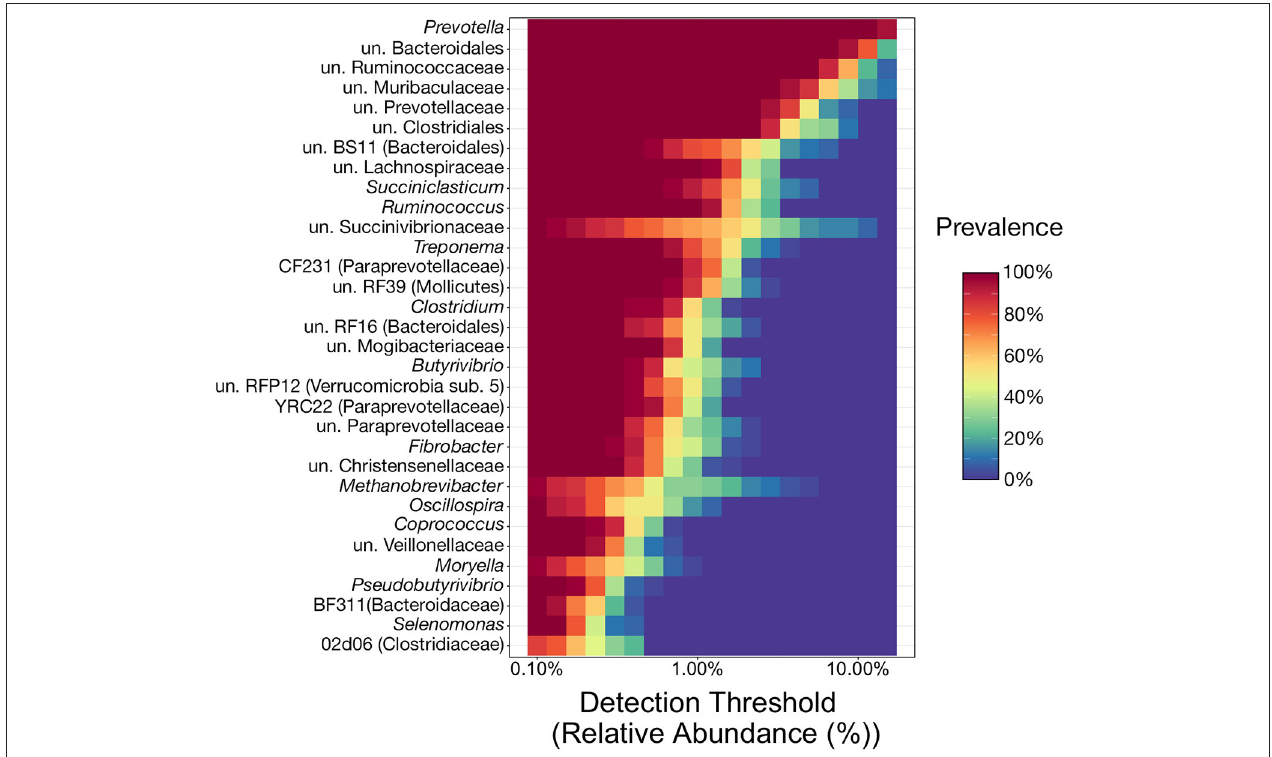
FIGURE 2 | Heatmap illustrating the microbial phylogenetic core of the bovine rumen in feedlot cattle at the taxonomic rank of genus. To be considered core taxa, genera needed to comprise more than 0.1% of the overall microbial community and be present in at least 80% of all samples ( n = 36). With the relative abundance values on the x-axis, the heatmap demonstrates the prevalence of the 32 genera considered core taxa at differing relative abundance levels (from the 0.1% minimum cutoff to the maximum observed value of 30.6%). This results in genera with high prevalence values at high relative abundances near the top of the heatmap, and those meeting the prevalence cutoff (80%) at lower relative abundances at the bottom. un,